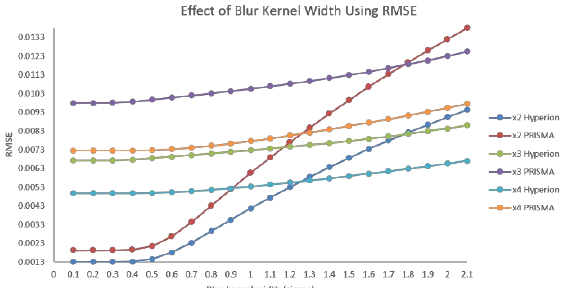
Figure 5. Effect of Blur Kernel Width Using RMSE on IBP’s Performance